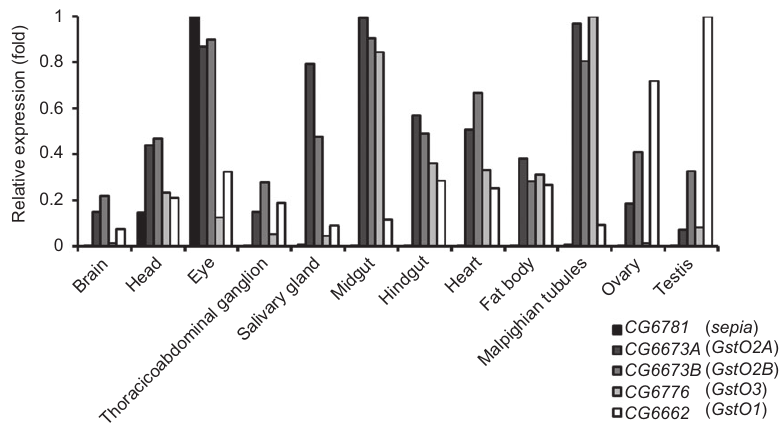
Figure 4 Tissue distribution of Drosophila GSTO mRNAs. The relative mRNA expression levels of GSTO genes in 12 different adult tissues are shown. CG6781 ( sepia ) mRNA is detected only in head and eye tissue. CG6662 ( GstO1 ) mRNA is primarily expressed in reproductive organs. The data on GSTO mRNA expression in adult tissues were compiled from Fly